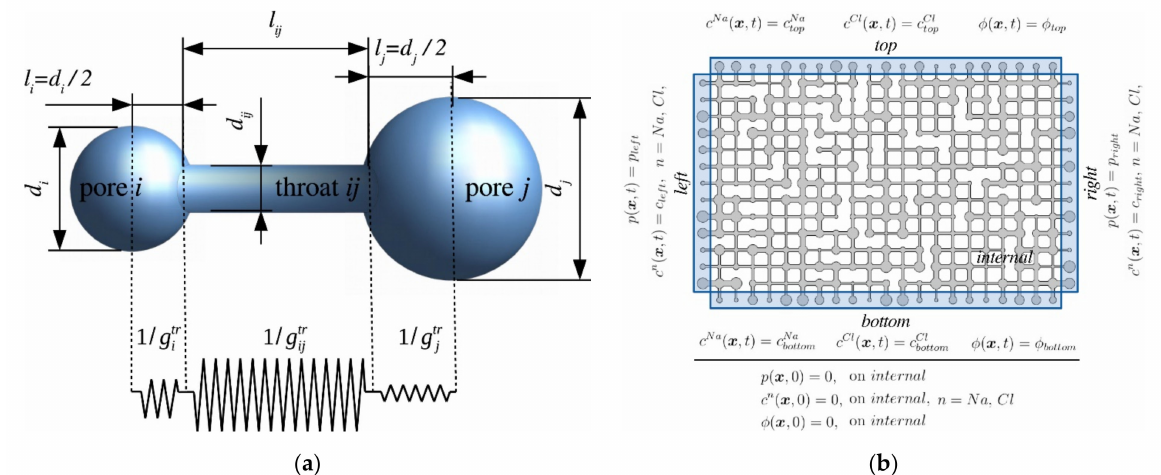
Figure 3. Diagram of ( a ) individual and ( b ) combined pore-throat-pore nodes. Each conduit consists of a throat, and half of each adjacent pore. Transport is described by size dependent resistance in series. The size and spacing of each pore is random [124]. Reprinted from Computers & Geosciences, Vol. 140, Agnaou, M.; Sadeghi, M.A.; Tranter, T.G.; Gostick, J.T. Modeling Transport of Charged Species in Pore Networks: Solution of the Nernst–Planck Equations Coupled with Fluid Flow and Charge Conservation Equations, pages No. 3–7, Copyright 2020, with permission from